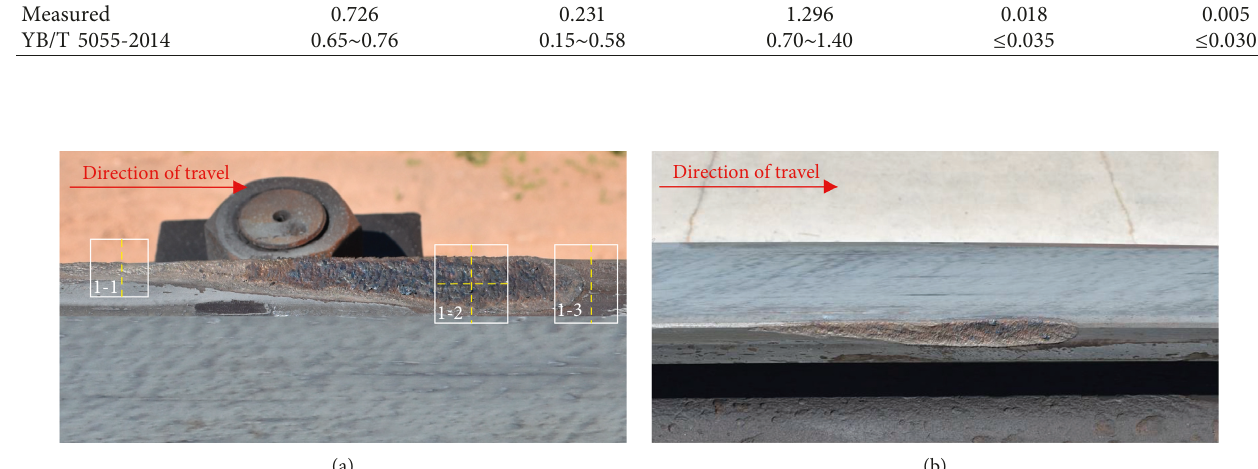
Figure 2: Morphology of typical gouges. (a) A gouge formed at the top rail surface. (b) A gouge formed at an edge of the